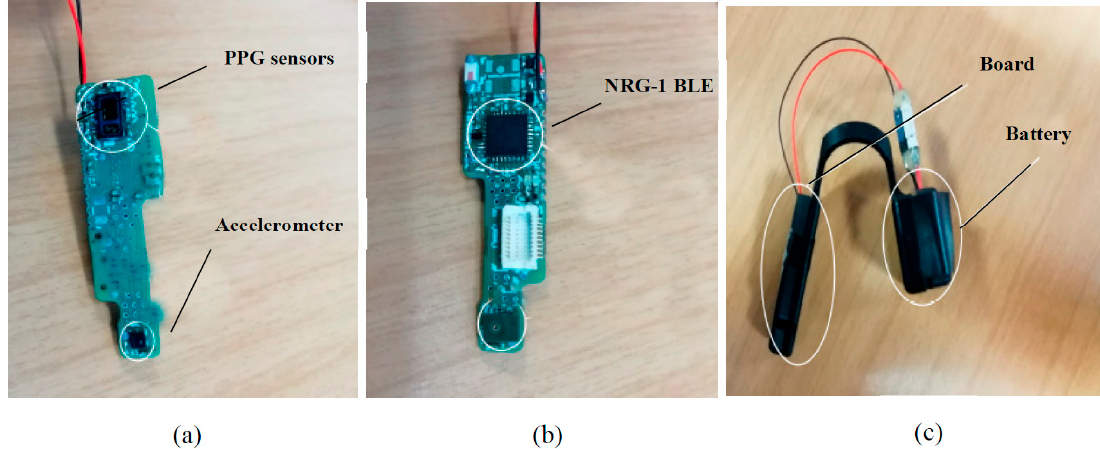
Figure 2. MORFEA, view of both sides with sensors ( a ), Bluetooth Low Energy (BLE) module ( b ) and the current case with the battery ( c ).